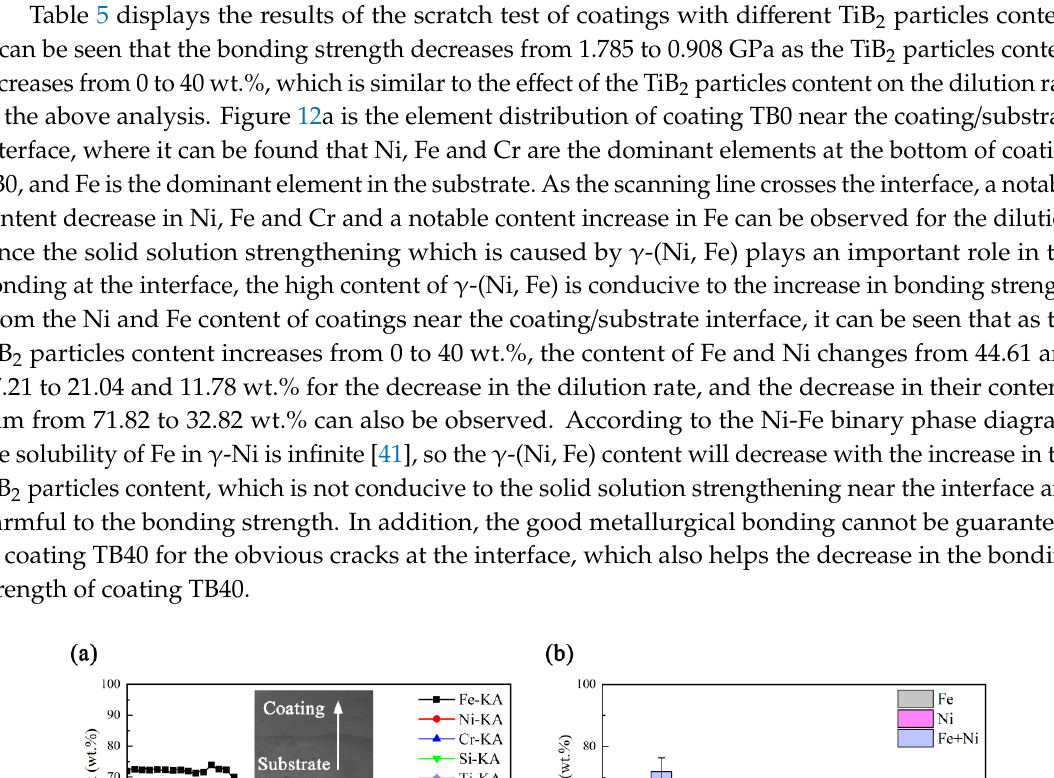
Table 5. Results of the scratch test of coatings with different TiB 2 particles content.